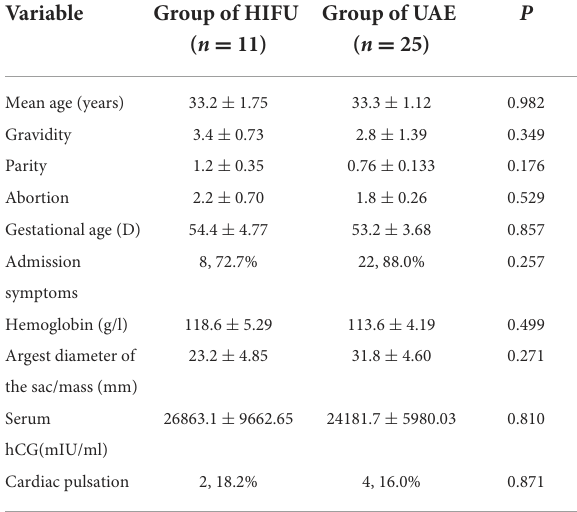
TABLE 1 Comparison of baseline characteristics between HIFU and UAE